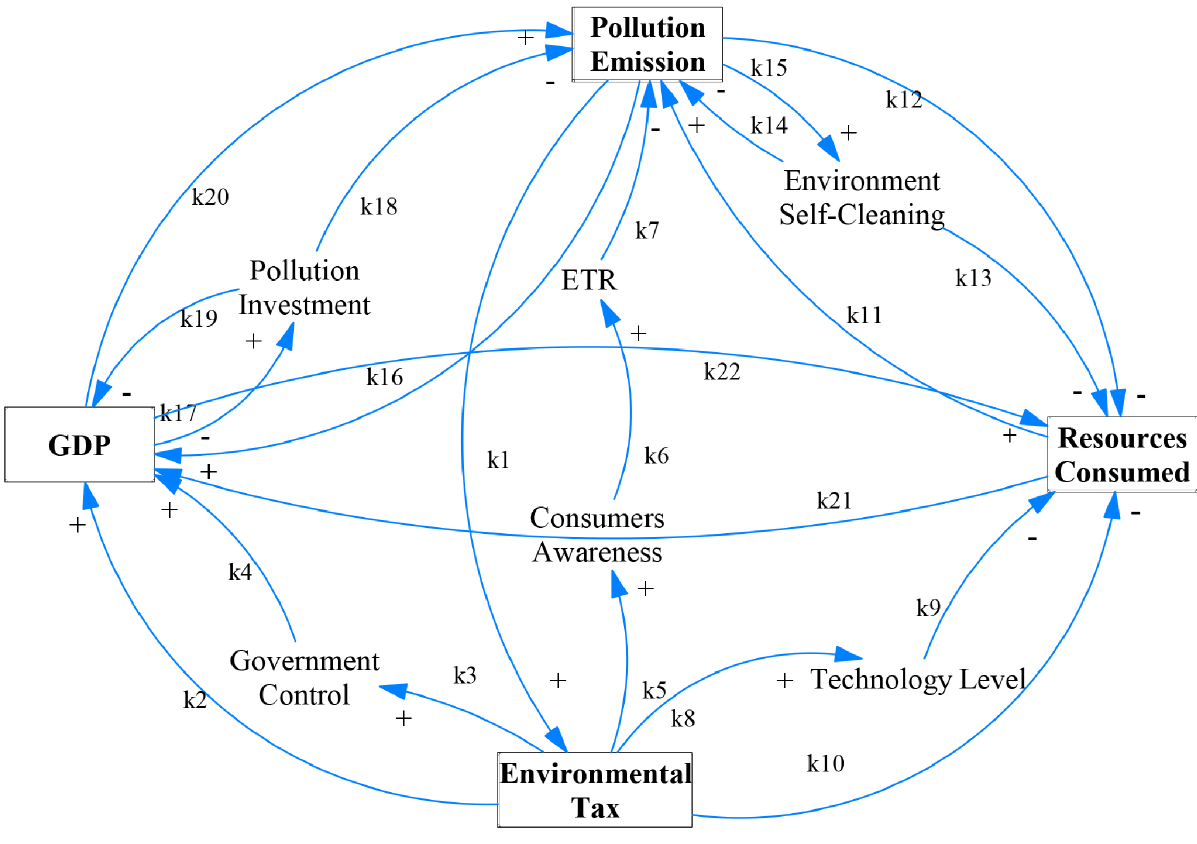
Fig 1. The interactions among the variables of